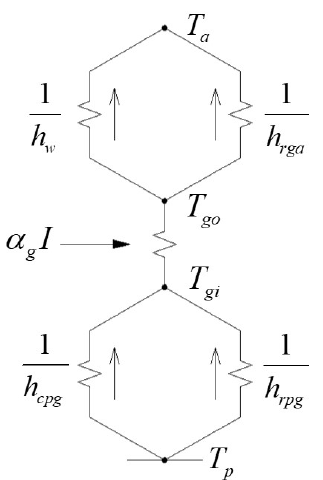
Figure 5. The thermal network for upward heat flow in a flat plate solar collector including the solar energy absorbed by the glass cover.